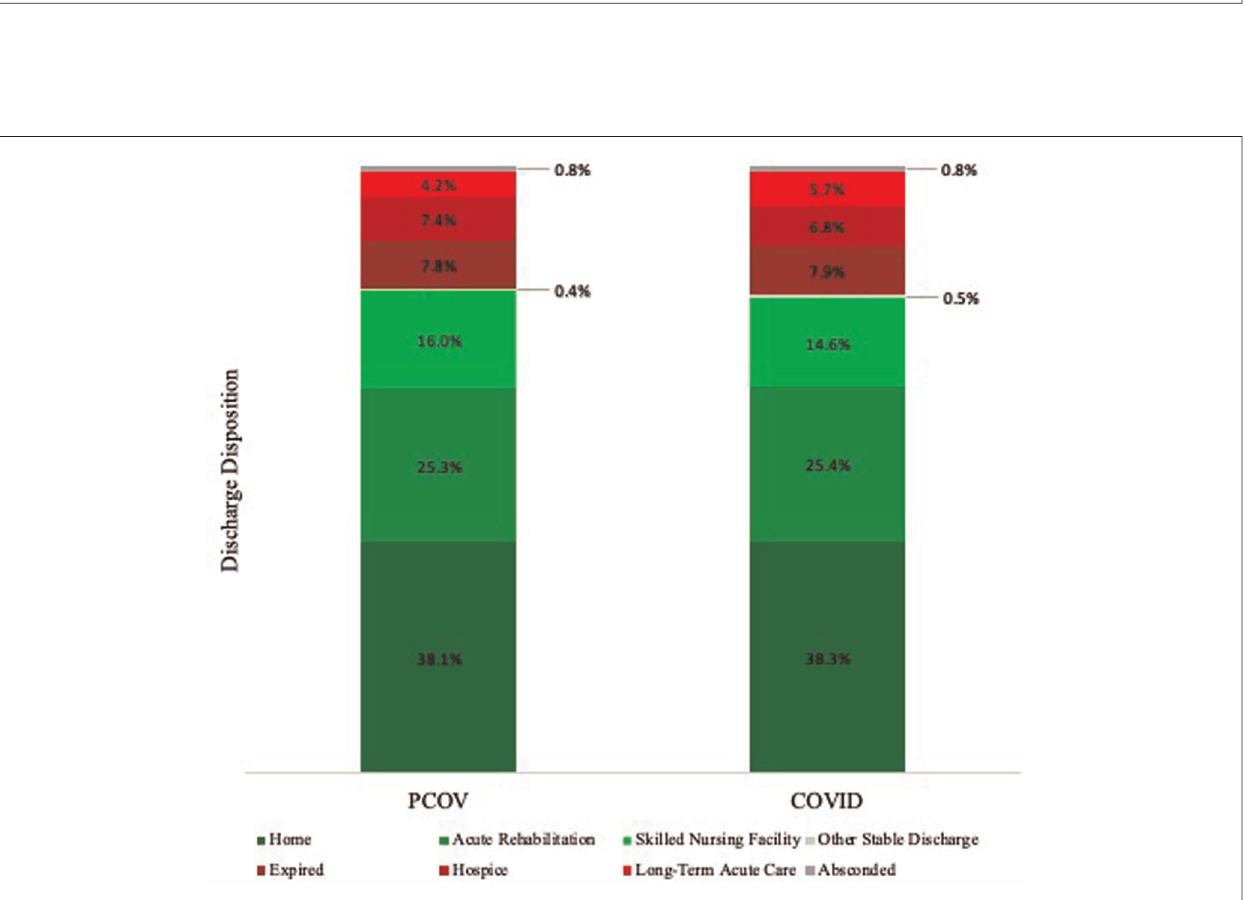
FIGURE 4 | Relative frequency of patient disposition following discharge from our hospital. *Note: Other Stable Discharge includes discharge of medically stable patients to various alternative facilities, including psychiatric hospitals, chemical dependence treatment facilities, and court/law enforcement.